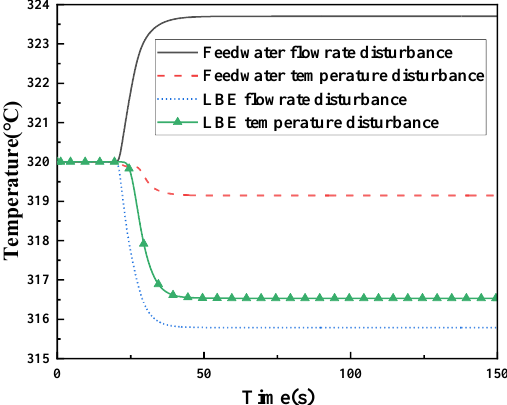
Figure 4. LBE outlet temperature variation under different disturbances.